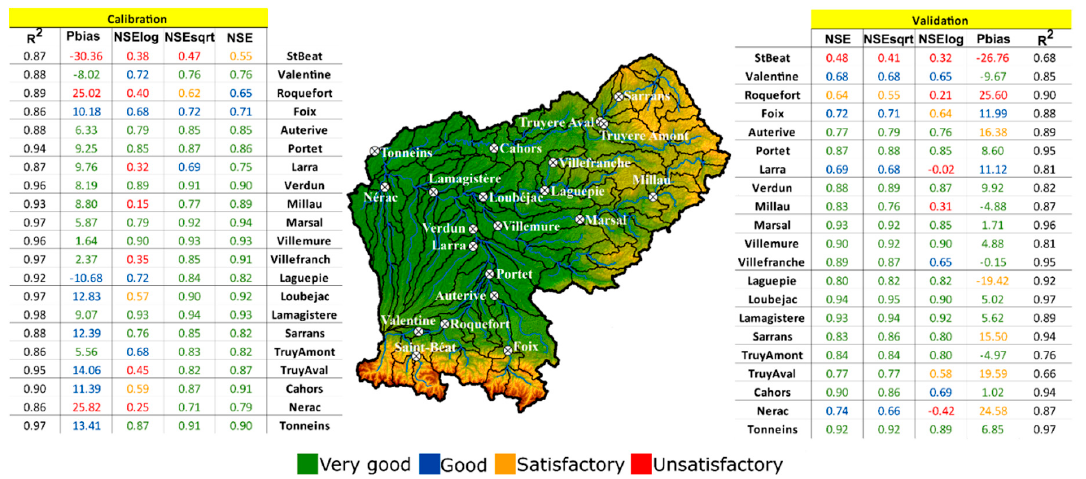
Figure 2. Performances in calibration and validation (following Moriasi, et al. [67] ).